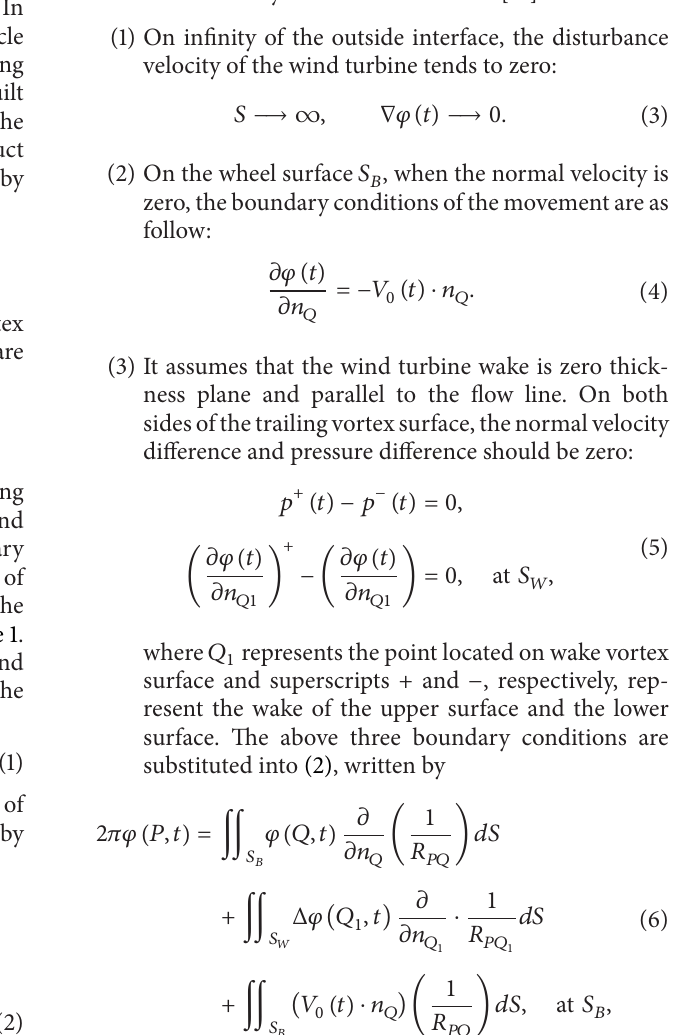
where, when 𝑃 included in the 𝑆 , 𝐸 = 1 ; 𝑃 at the boundary of 𝑆 , 𝐸 = 1/2 ; and 𝑃 at outside of 𝑆 , 𝐸 = 0 . 𝑅(𝑃, 𝑄) is the length of the field point 𝑃 and the point 𝑄(𝑥 0 , 𝑦 0 , 𝑧 0 ) . 𝜕/𝜕𝑛 𝑄 represents the normal derivative of the point 𝑆 , which satisfies the various boundary conditions as follows